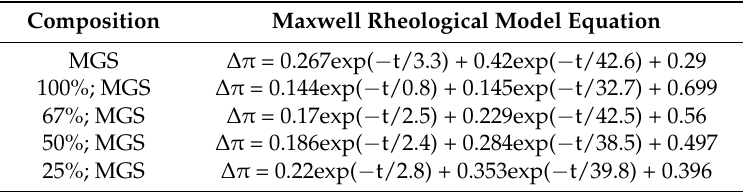
Table 1. Maxwell rheological model equations for MGS film samples. All the equations fit the raw transient at Figure 4 with R 2 ≥